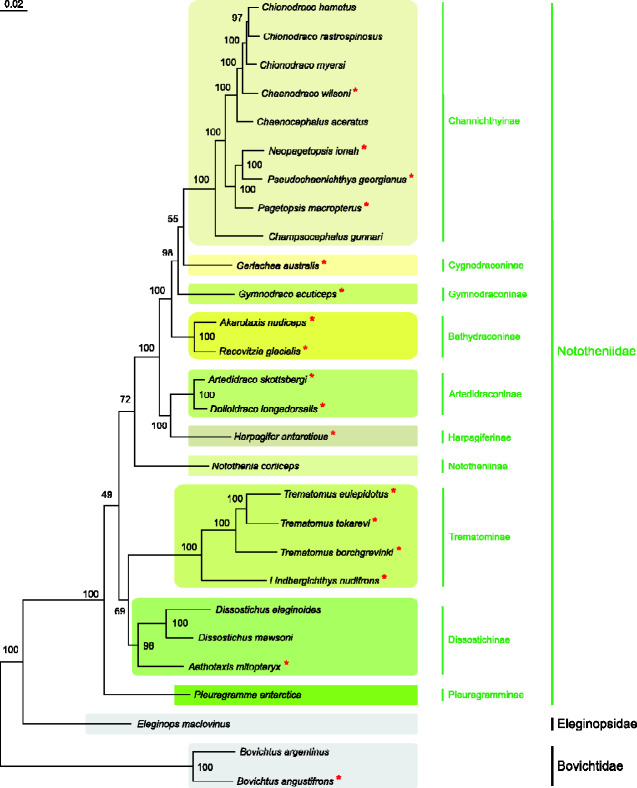
Maximum Likelihood tree (−ln = 145,314.7783) obtained from the analysis performed on the 28 T.Mito + 28 T.Nucl multiple alignments by applying the GTR+FO×H4 heterotachous model to the two s. Ultrafast bootstrap values are provided for each node. The scale bar represents 0.2 substitutions/site. Species whose genomes were sequenced de novo in this study are indicated by an asterisk.